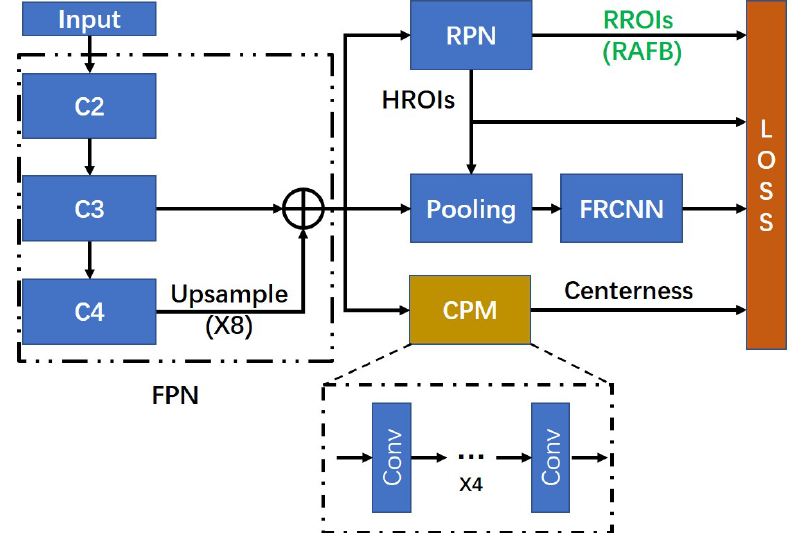
Figure 3. The proposed network structure. The backbone feature pyramid network is denoted by “FPN.” The “HROIs” and “RROIs” respectively indicate the horizontal ROIs and rotational ROIs predicted by the region proposal network (RPN). Specifically, RROIs are predicted by the proposed rotation-anchor-free branch (RAFB) in the RPN, which is highlighted by green. Meanwhile, the proposed center prediction module (CPM) predicts the center coordinates of bounding boxes, which is denoted by gold in the figure. As both RAFB and CPM are utilized during training, only the HROIs is used on the pooling layer and the fast RCNN module